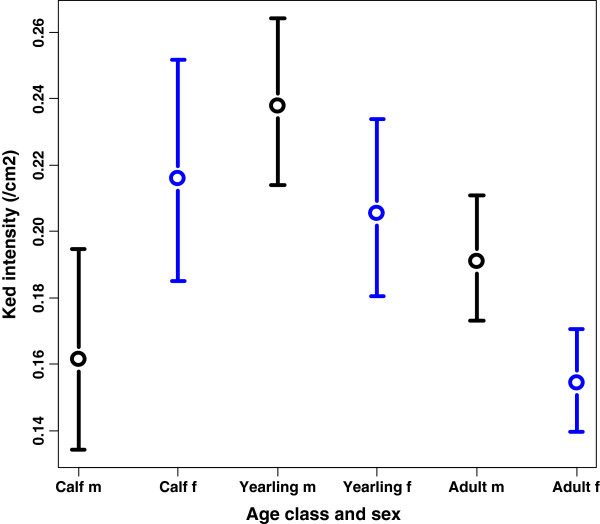
Predicted deer ked intensity (mean ± SE) by sex and age class in moose, at average values of covariables from best model. Male (m) and female (f) moose in the following age classes; calf (~ 0.5 years), yearlings (~1.5 years) and adult (> 2.5 years).